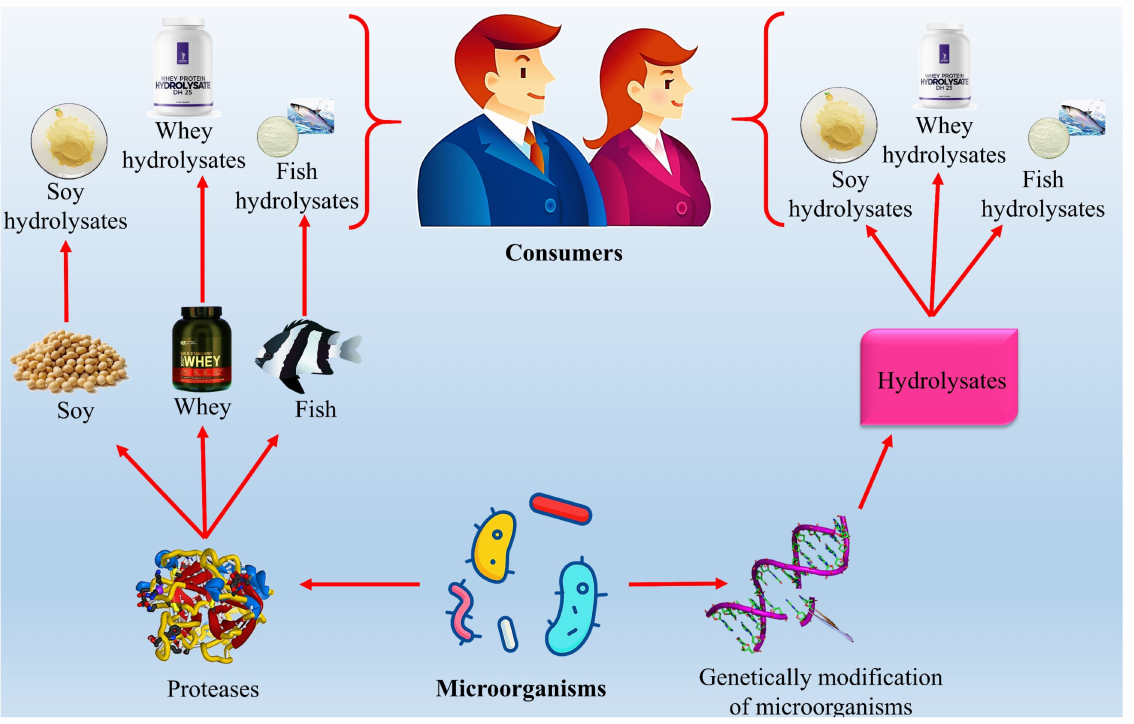
Figure 7. The application of fungal proteases in the food